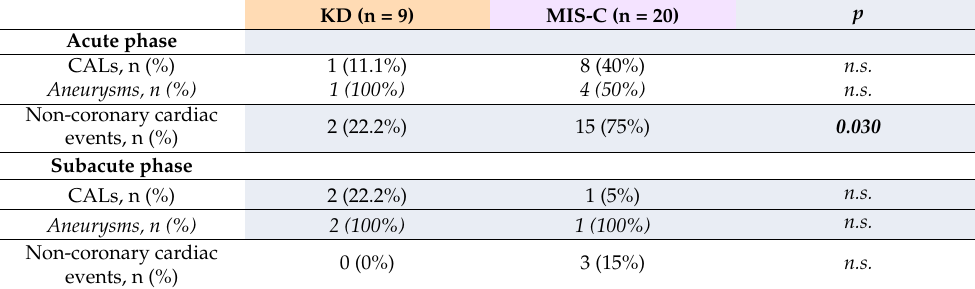
Table 2. Coronary involvement in KD and MIS-C groups during acute and subacute